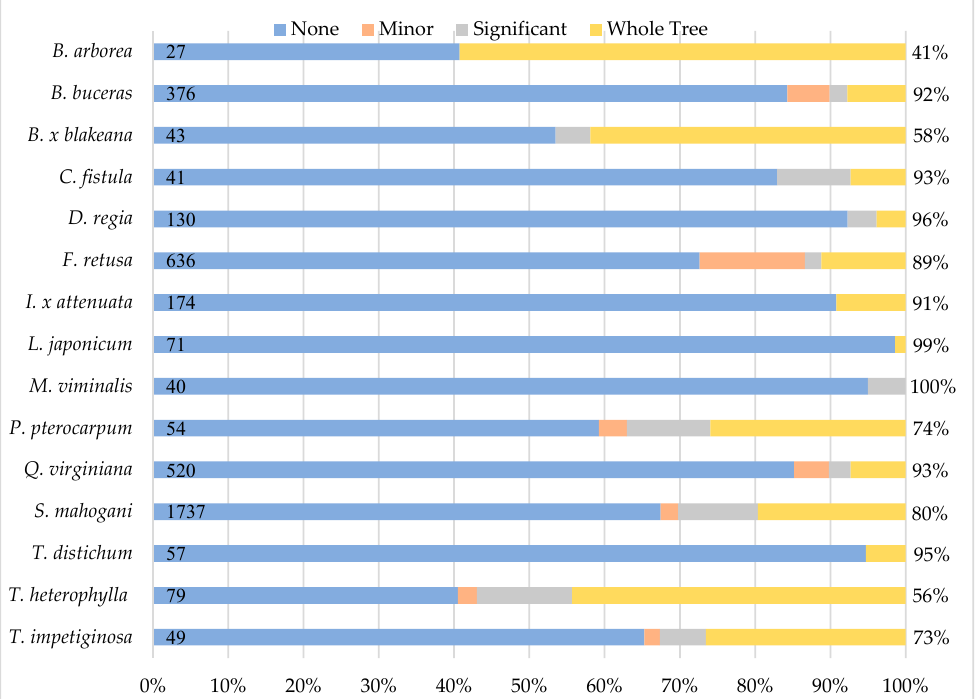
Figure 2. Proportion of each damage type (described in the text) for each species. Numbers at the left edge of each bar indicate the sample size excluding individuals not found in post-hurricane assessments; numbers at the right edge of the chart indicate survivorship, computed as the proportion of trees of each species rated as having no damage, minor damage, or significant damage after the hurricane. Complete binomials are in Table 1. Species differences also existed with respect to the proportion of individuals in each damage category (Figure 2). For five species ( D . regia , I . × attenuata , L . japonicum , M . viminalis , T . distichum ), more than 90% of individuals sustained no damage. For an additional four species ( B . buceras , C . fistula , F . retusa , Q . virginiana ), more than 80% of individuals sustained no or minor damage. The remaining six species fared worse. For B . arborea and T . heterophylla , more than 50% of individuals sustained significant damage or whole-tree failure; for the remaining four species ( B . blakeana , Peltophorum pterocarpum (DC.) Backer ex K.Heyne, S . mahogany , Tabebuia impetiginosa (Mart. ex DC.) Standl.), at least 30% of individuals sustained significant damage or whole-tree failure. Table 2 includes the output from the ordinal logistic regression. We excluded F . retusa from the model because of its uniquely large DBH values and used Q . virginiana as the comparison species because previous studies have shown it to be a storm-resistant species [5,11,12]. Species, DBH, and the presence of utility lines influenced the proportion of individuals in each damage category. For each cm increase in DBH, the odds of an individual moving to a lesser damage category increased by a factor of 1.01. Similarly, individuals near utility lines were 9.09 times more likely to be in a lower